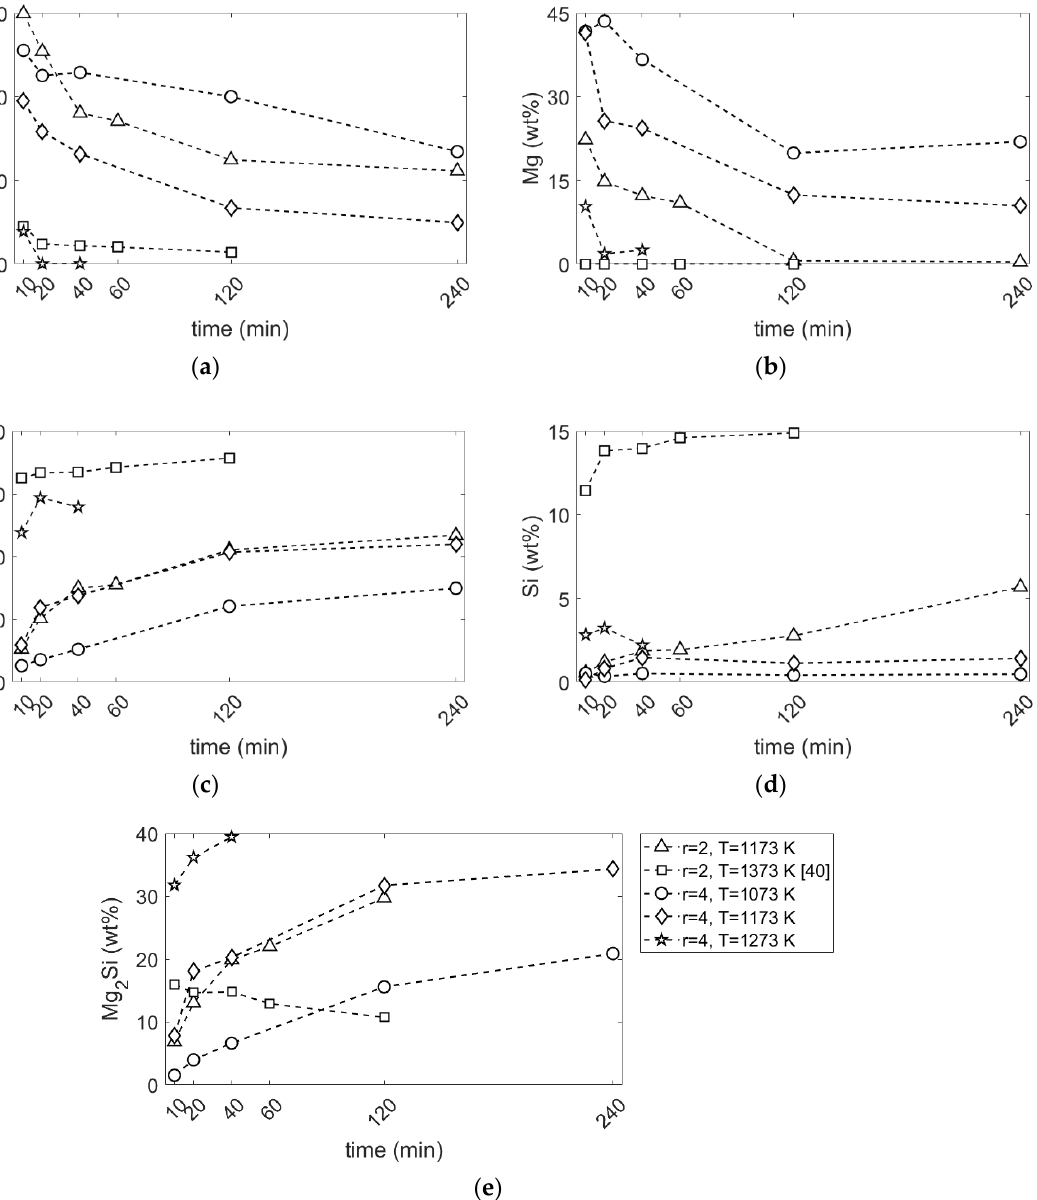
becomes slightly faster after this point since Si was formed through two reactions: SiO 2 reduction and conversion of Mg 2 Si to Si.